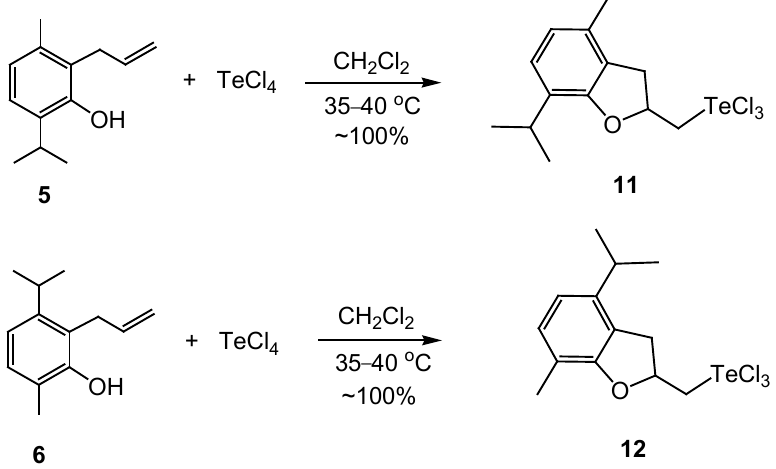
Scheme 6. Synthesis of tellanes 11 and 12 by the reaction of tellurium tetrachloride with allyl thy- mol 5 and allyl carvacrol 6 .